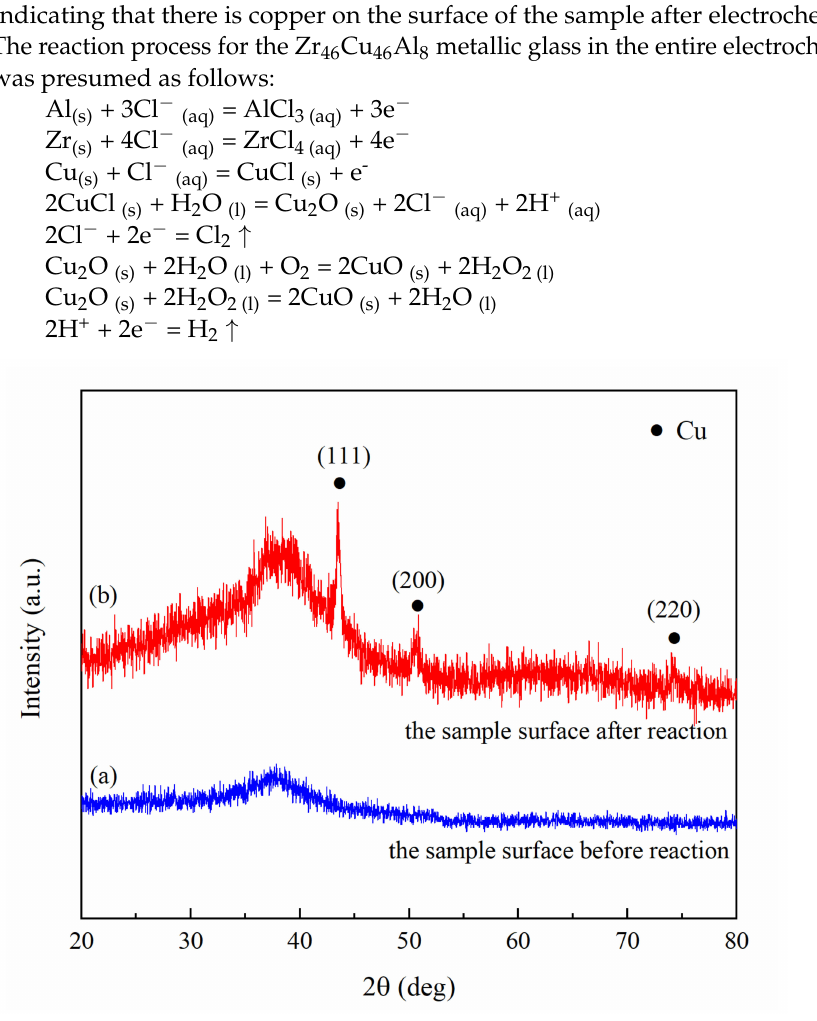
Figure 2. XRD pattern of the sample surface before ( a ) and after ( b )